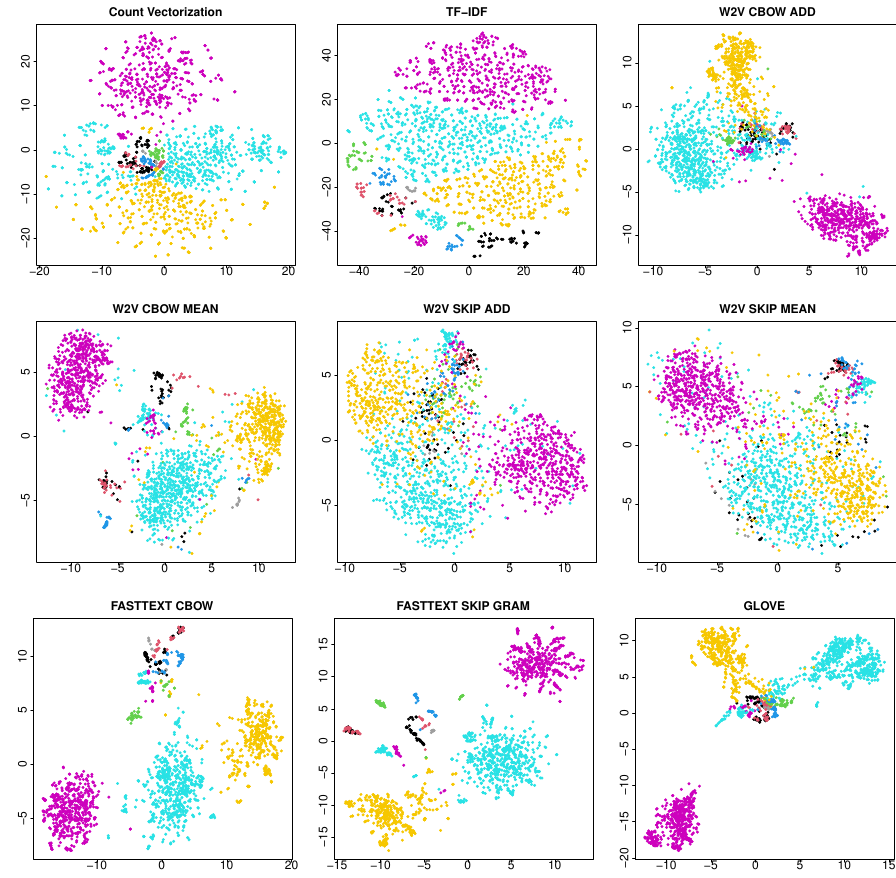
Figure 4. 2D visualization for the product name-embedding.